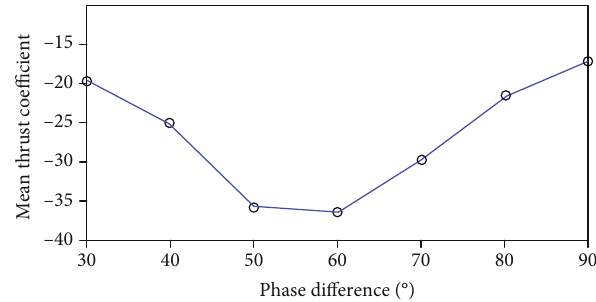
Figure 9: Mean thrust coe ffi cient diagram of caudal fi n under di ff erent phase di ff erence.